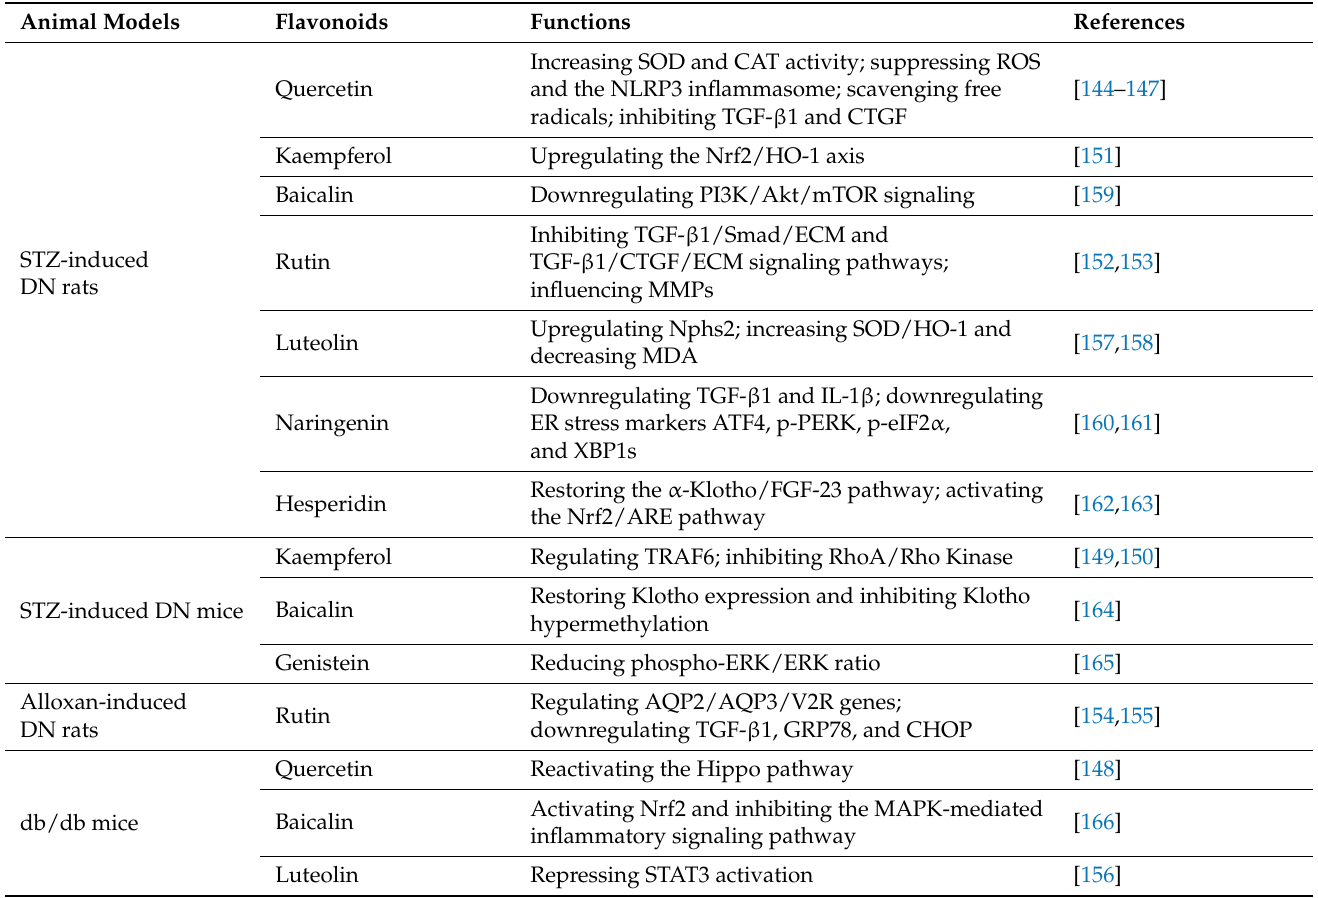
Table 2. Flavonoids in diabetic